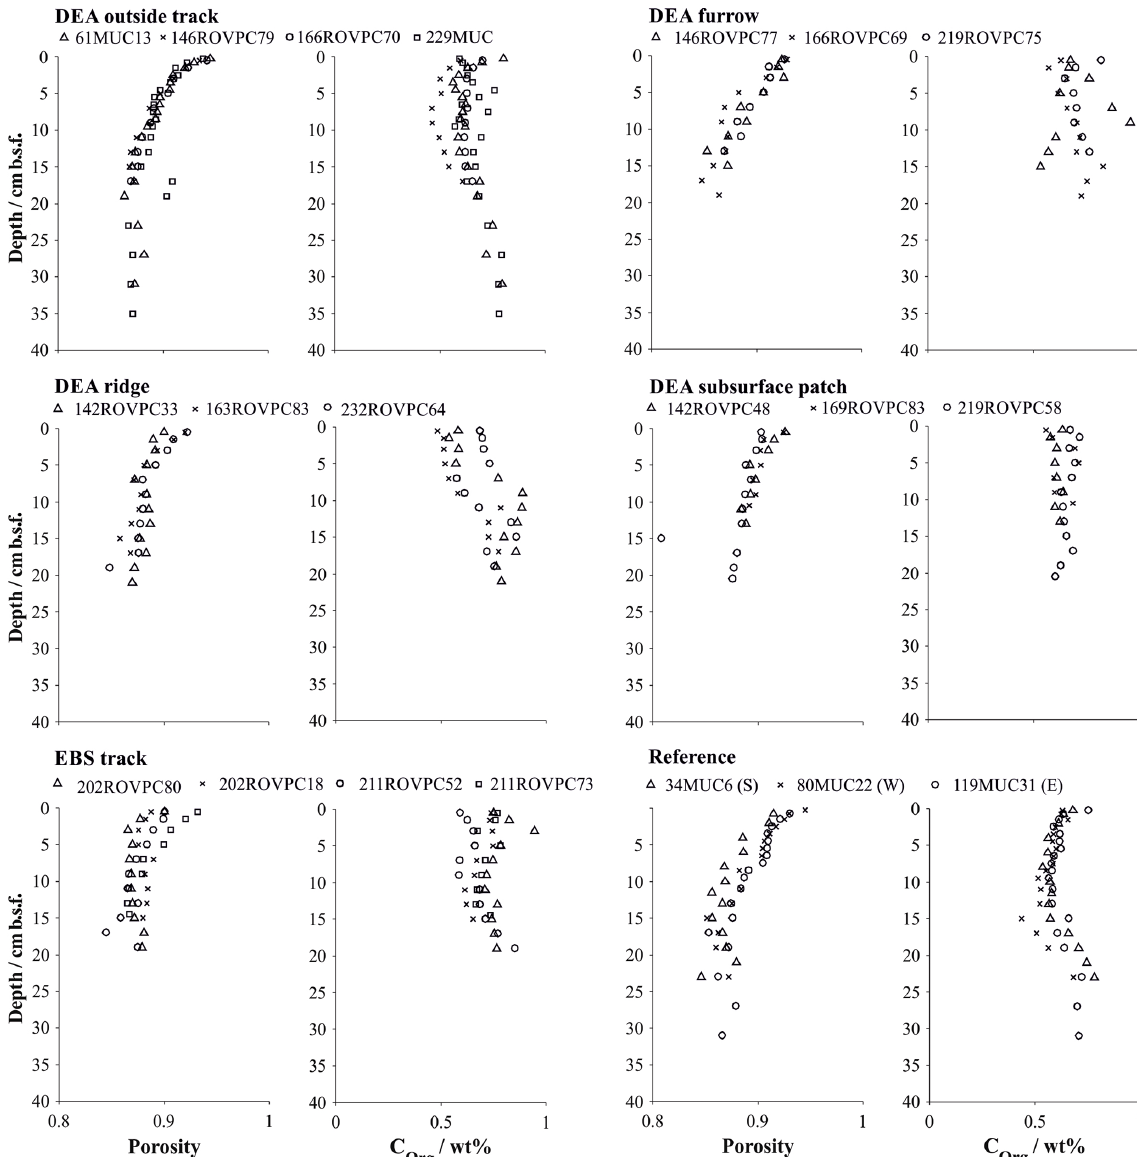
Figure 4. Porosity and organic carbon content in multiple and box cores retrieved in various microhabitats (Paul et al., 2018). Symbols represent the measured values at the mean depth of the sediment layer sampled. Details on individual sampling stations can be found